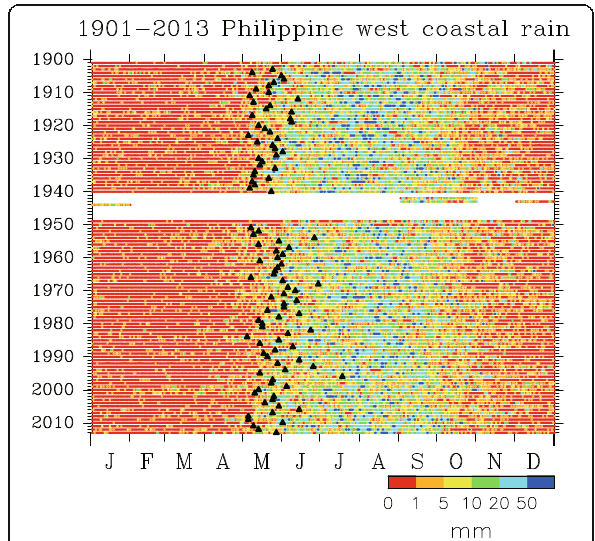
Fig. 4 Daily rainfall averaged at eight northwest Philippine stations during 1901 – 2013. Triangles indicate Philippine summer monsoon onset dates defined by rainfall data using the criteria (1 – 3) listed in the text